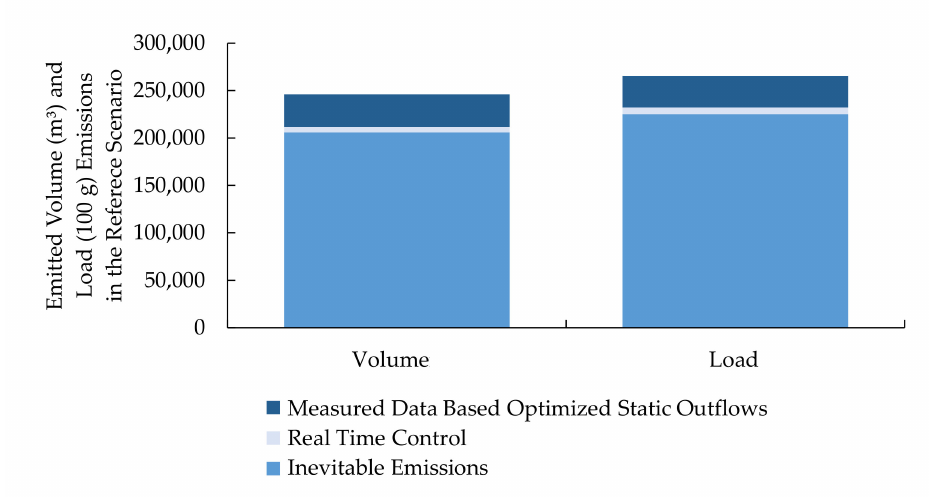
Figure 8. Emitted volume and load in the reference scenario, after measured data-based optimization, with real-time control and inevitable system